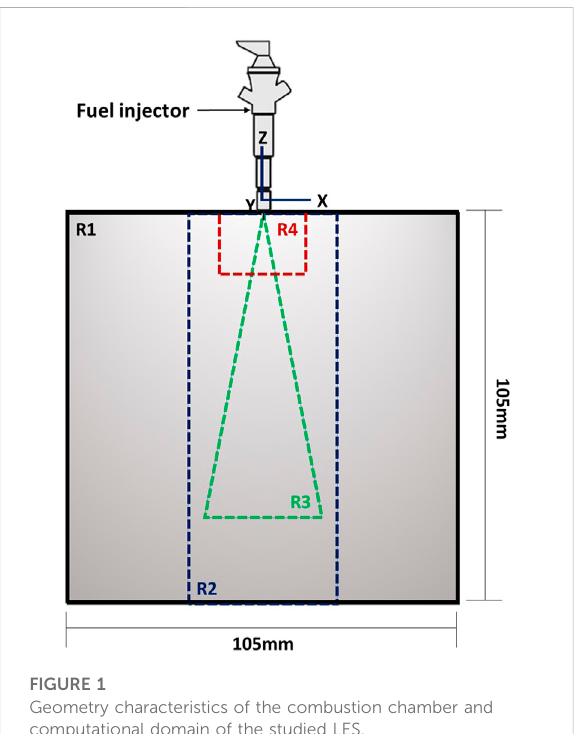
TABLE 1 Modeling and constant values of the numerical parameter.